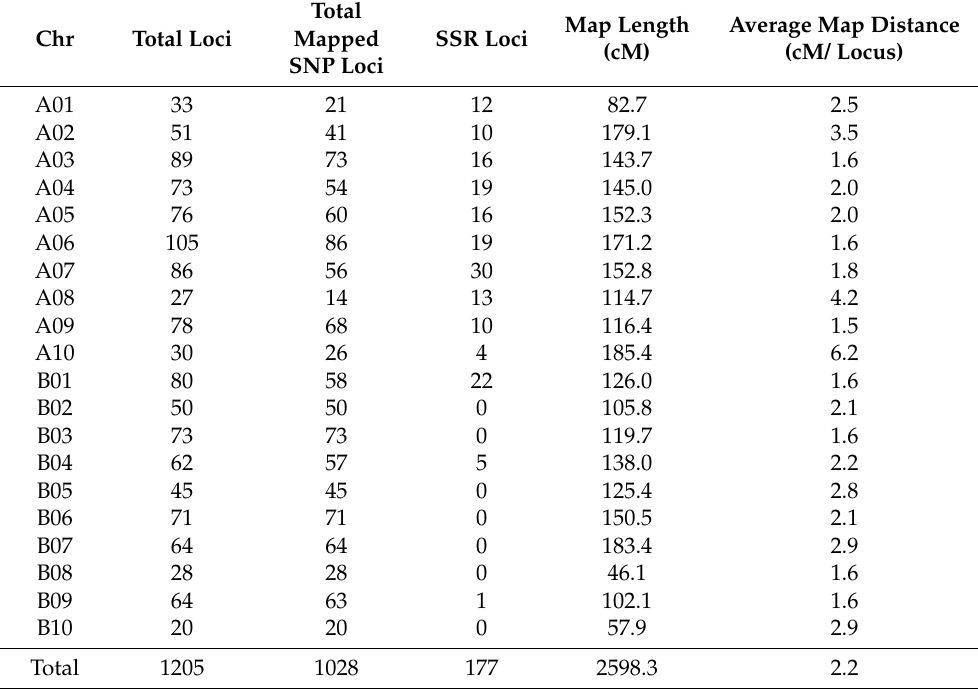
Table 2. Summary of genetic map constructed using single nucleotide polymorphism (SNP) and simple sequence repeat (SSR)